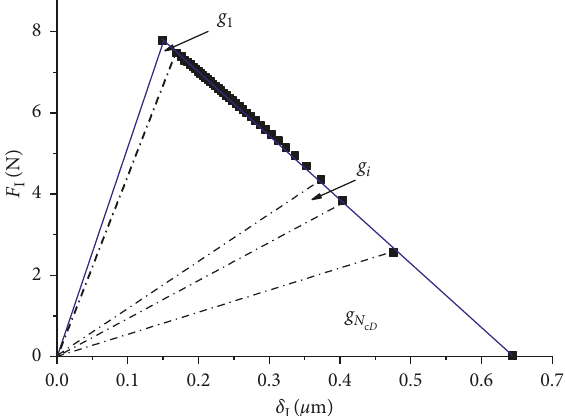
Figure 14: Evaluation of the energy release at the crack tip (contact C 1 ) during a fatigue test.